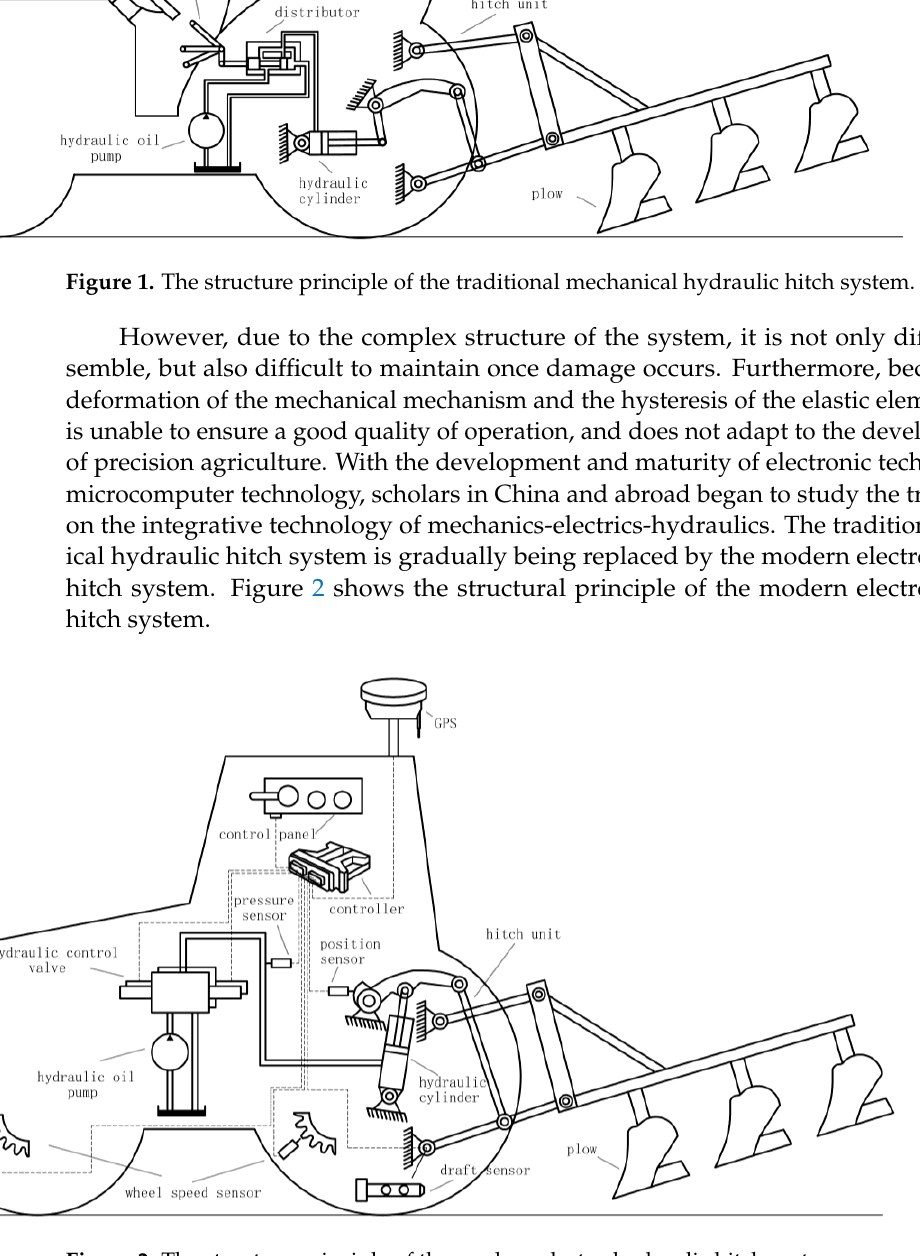
Figure 2. The structure principle of the modern electro-hydraulic hitch